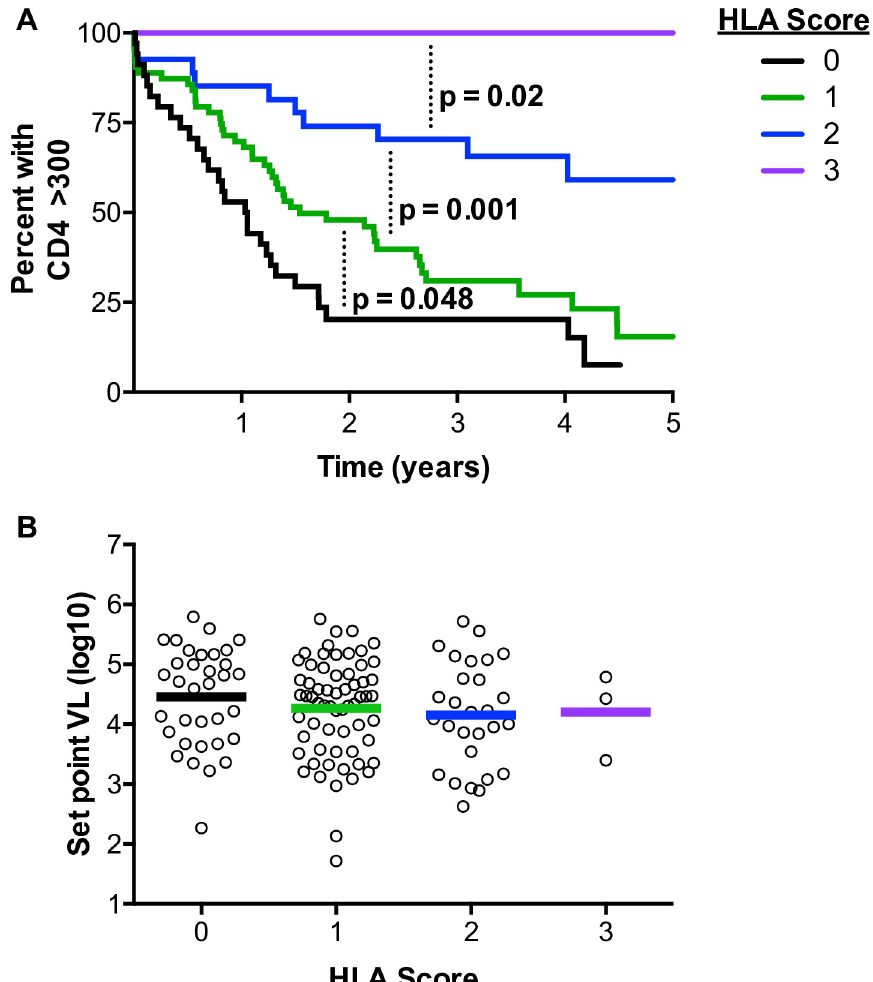
Fig 1. Multiplicities of protective HLA alleles and their additive effects on CD4+ T cell decline and set point viral loads. HLA-B � 1401, B � 57, B � 5801, B � 81, HLA-DQB1 � 02, and HLA-DRB1 � 15 were defined as CD4-protective in this cohort. (A) Kaplan-Meier survival curves, with an endpoint defined as CD4 counts < 300/ μ l, demonstrating the effect of carriage of increasing numbers of protective HLA alleles on CD4+ T cell decline. P-values represent significantly different decline trajectories between adjacent groups and were generated from a Cox proportional hazards model. (B) Mean set point viral loads between individuals carrying increasing numbers of protective HLA alleles.